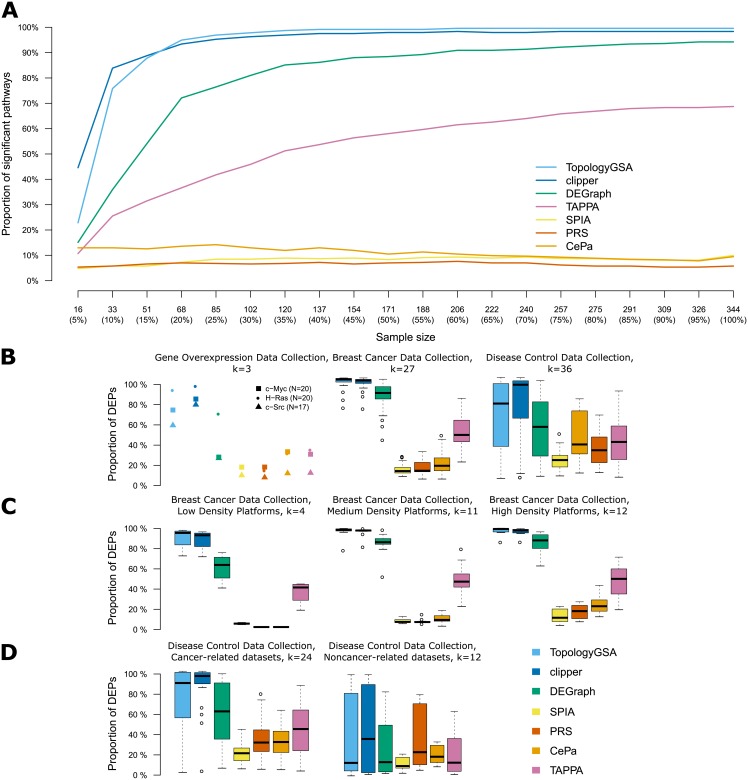
The effect of sample size.(A) The selected dataset from Breast Cancer Data Collection (denoted as VDX) was reduced to 20 random subsets representing 5%, 10%, … 95% of its original sample size (while preserving the proportion of samples in the clinical groups) leading to sample sizes from 16 to 326. Differentially expressed pathways between estrogen receptor positive and negative samples were detected. The lines show the median proportion of significant pathways (p < 0.05) over 20 subsets for each sample size. (B-D) Graphs indicating the percentage of differentially expressed pathways (DEPs) in the respective data collections. k denotes the number of datasets. See Table 3 for the summary of sample sizes. The datasets from the Breast Cancer Data Collection were divided by platfrom densities into: low-density platforms (2780-5486 EntrezIDs), medium-density platforms (9041-13091 EntezIDs) and high-density platforms (17779-20389 EntrezIDs).